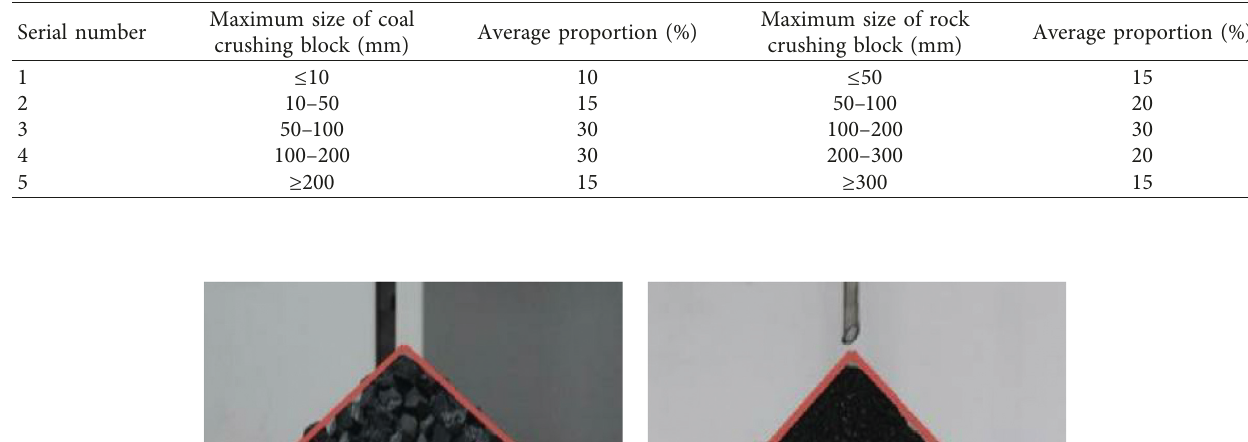
Table 1: Proportion of blocks with different sizes in surrounding rock collapse.